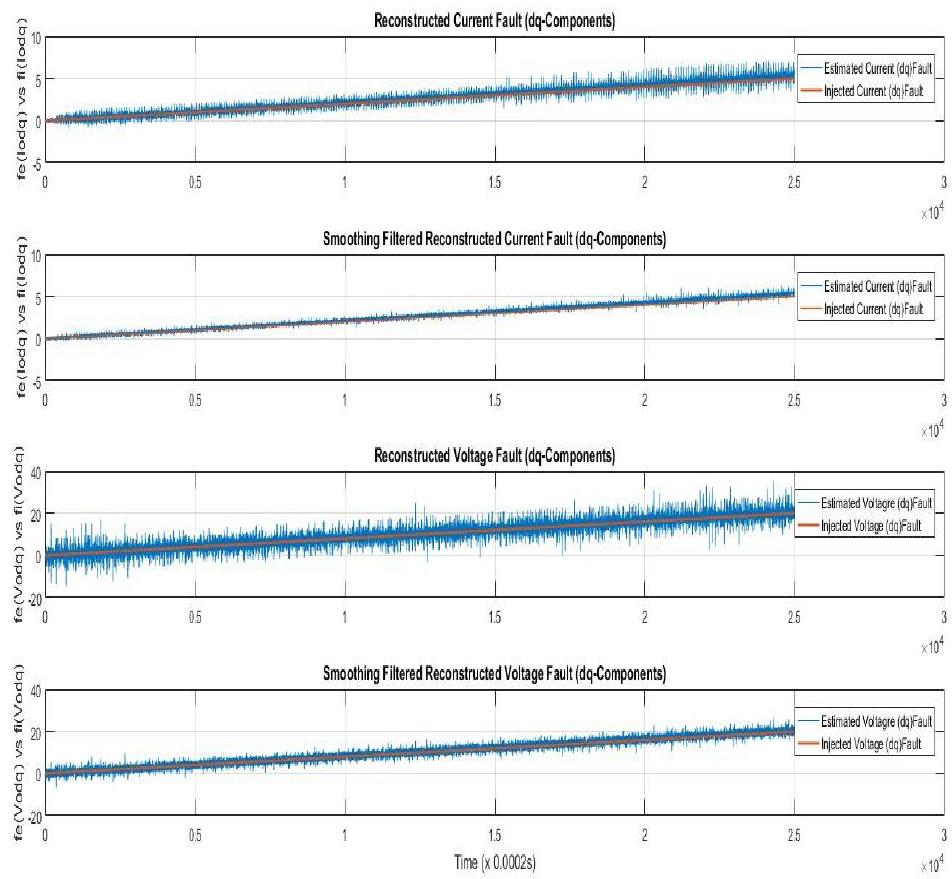
Figure 15. Current (dq) and voltage (dq) fault reconstruction (ramp